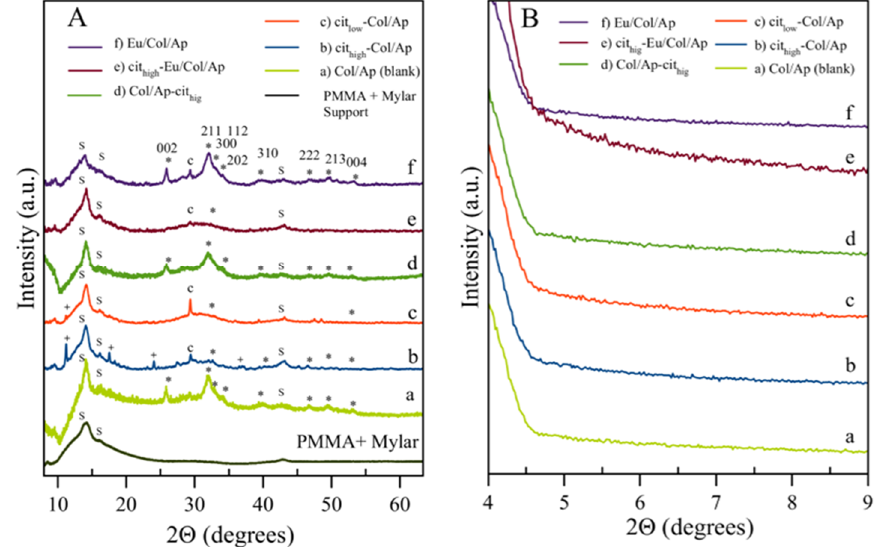
Figure 1. VPSEM micrographs of some selected mineralized fibrils of Table 1: a ) Col/Ap, b ) cit high